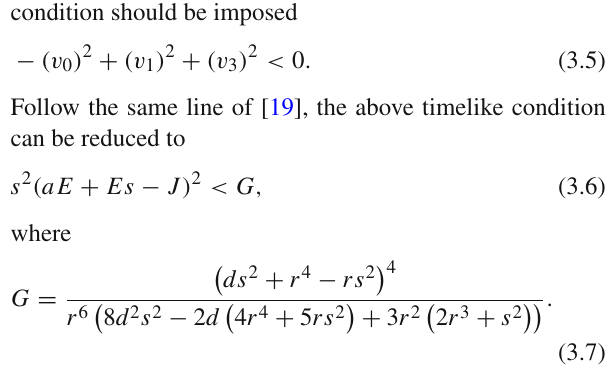
Fig. 3 Allowed region of spin s when d = − 0 . 24 (red) and d = 0 . 08